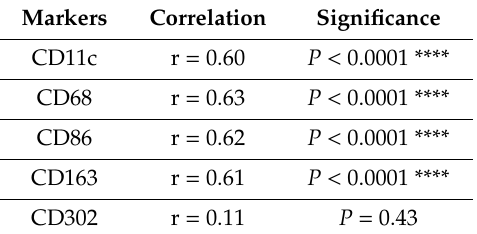
Table 4. Correlation of adipose IRF5 gene expression with monocyte / macrophage markers. Markers Correlation Significance CD11c r = 0.60 CD68 r = 0.63 CD86 r = 0.62 r = 0.61